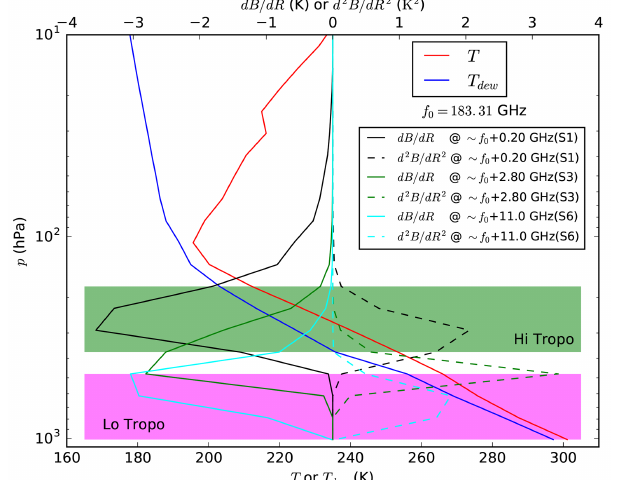
Figure 4. Brightness temperature deviations calculated for different levels in the troposphere (as shown in Fig. 3), various turbulence intensities, ε in cm 2 s − 3 , and adjusted offsets in temperature and humidity. Blue dots are values of observed minus calculated bright- ness temperatures between the SAPHIR Megha-Tropiques instru- ment vs. Météo France NWP profiles plus the RTTOV v11 RTM (from Brogniez et al.,